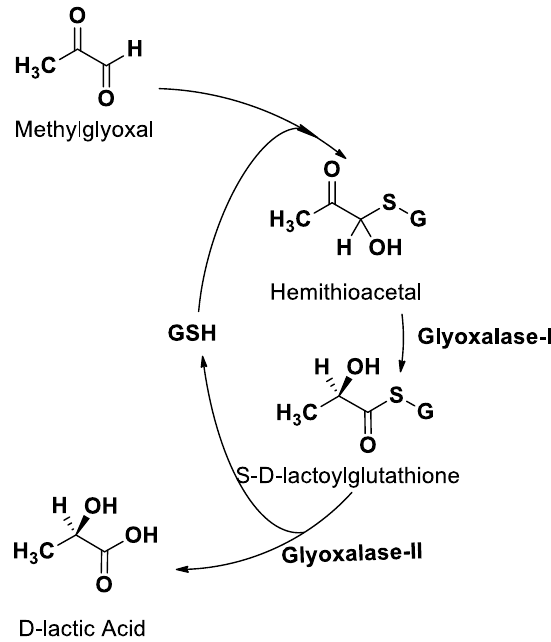
Figure 1. Detoxification of methylglyoxal by the glyoxalase system.